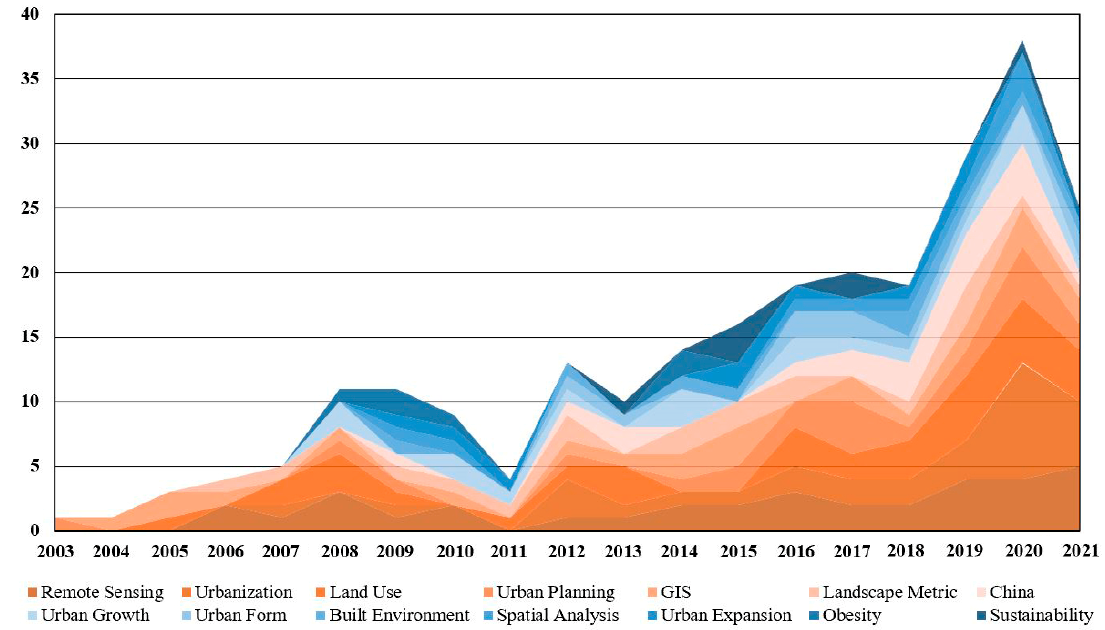
Figure 2. Keywords in the literature of urban sprawl.